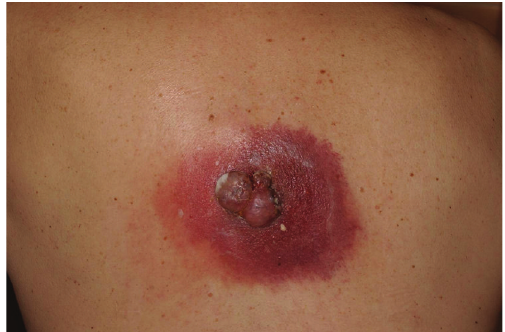
Figure 5: Case 3: An exophytic, ulcerated tumor mass in the middle of the back, with suppurative inflammation and abscess formation.